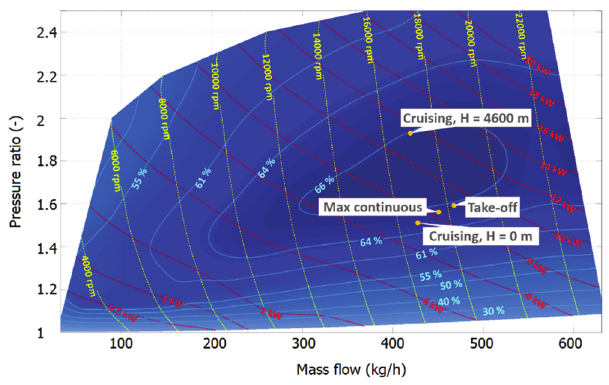
Fig. 9. Eaton TVS R410 compressor map with calculated operating points [13]